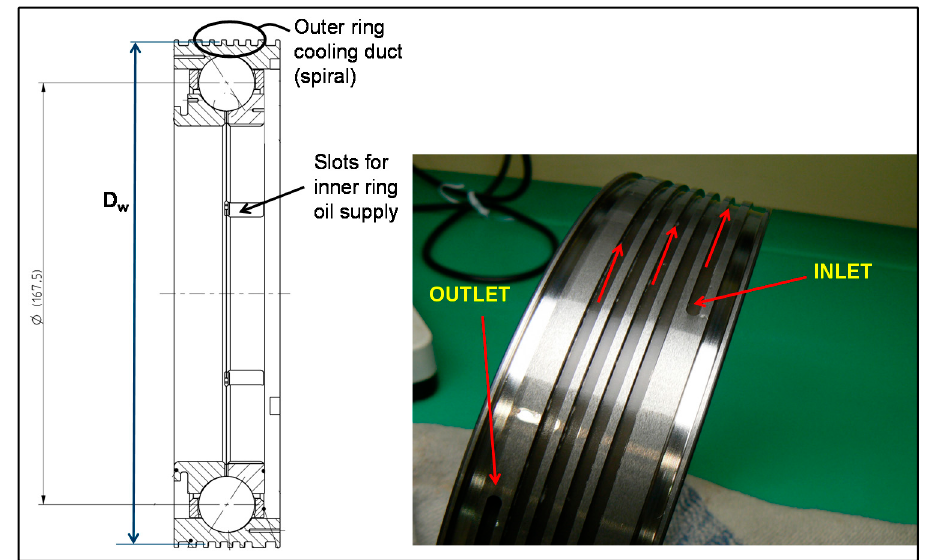
Figure 1. The bearing outer ring cooling arrangement.